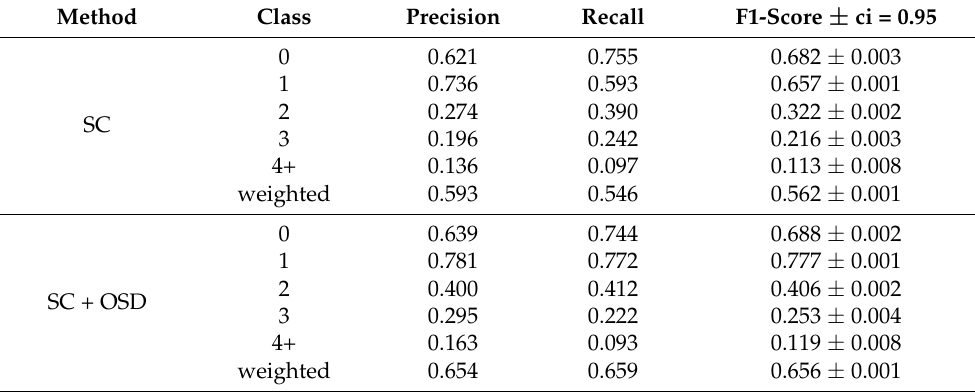
Table 5. Speaker counter and overlapping speech detector fusion